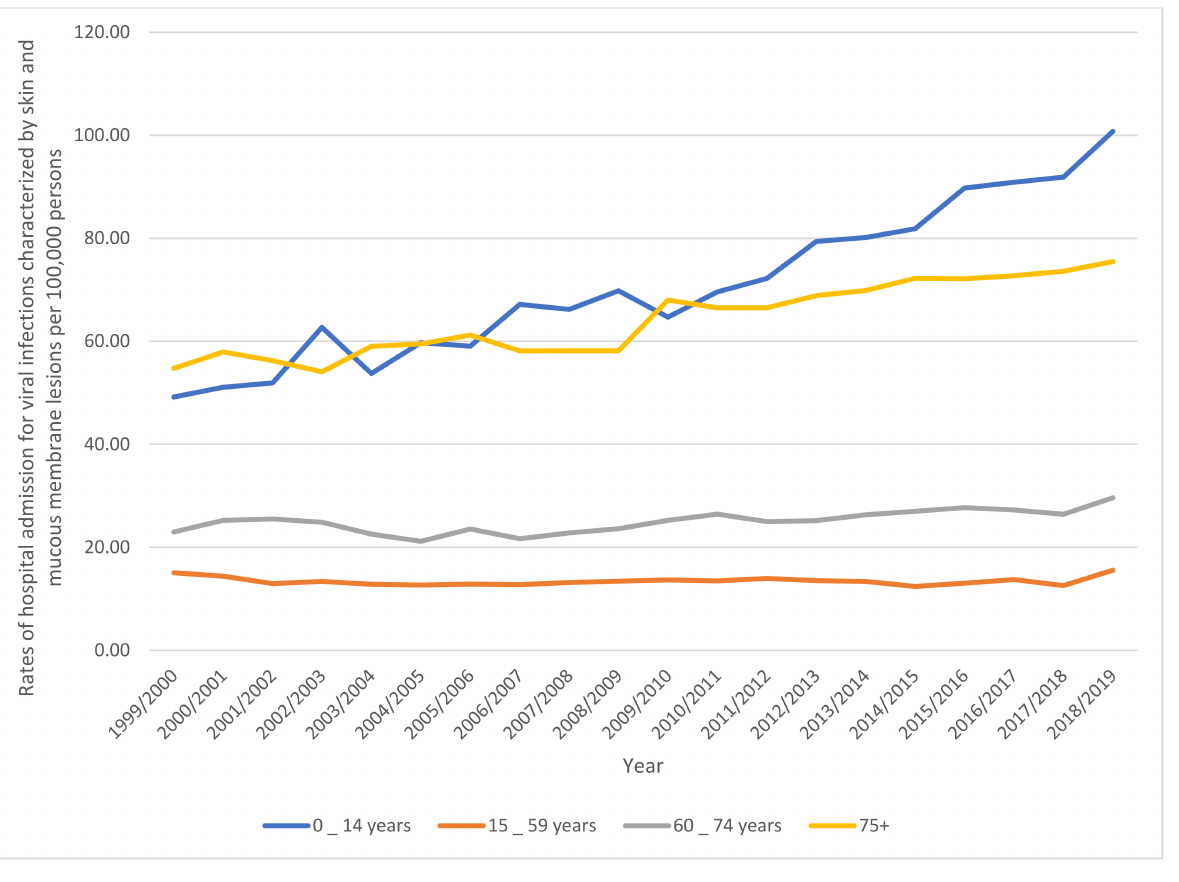
Figure 2. Rates of hospital in England and Wales stratified by age